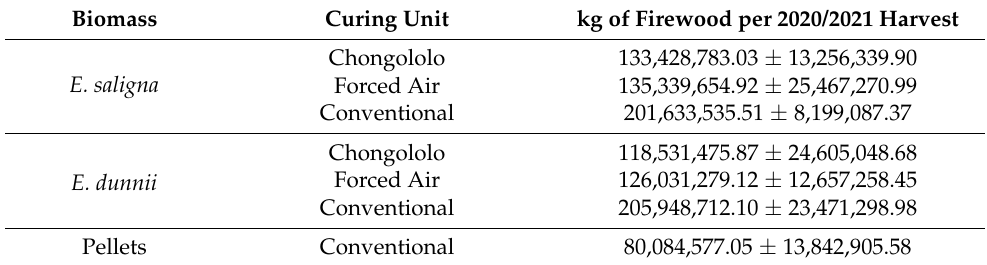
Table 3. Quantification of biomass consumption considering the different scenarios of curing units and biomass.